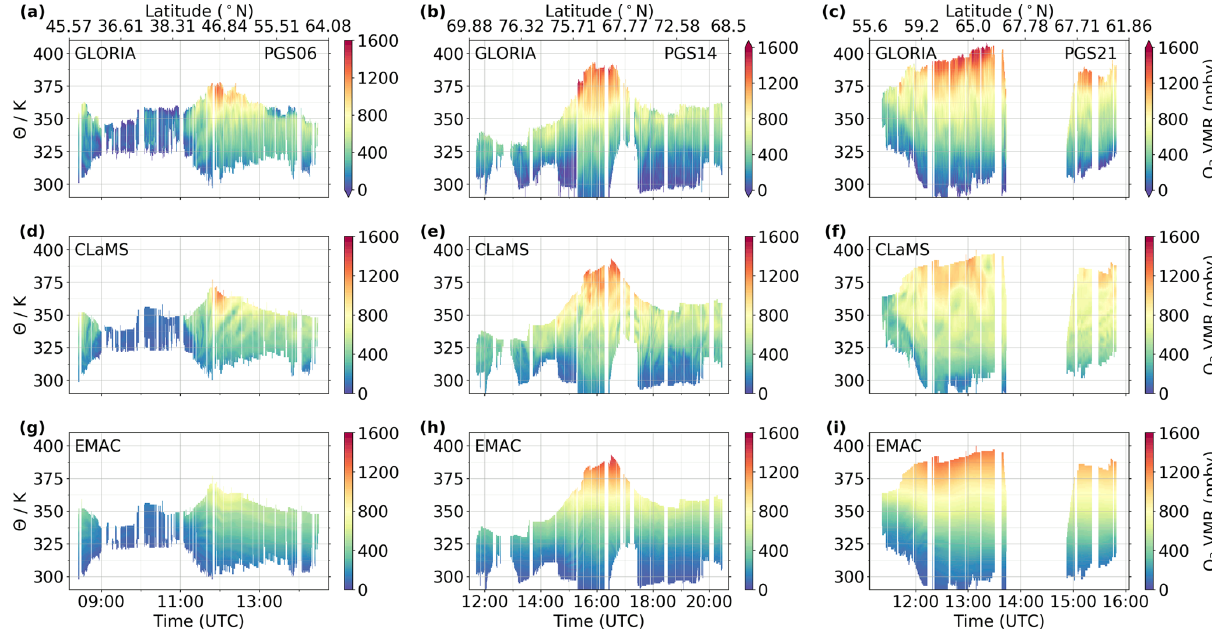
Figure 8. Comparison of GLORIA-measured ( a, d, g , repeated from Figs. 5 to 7 with a different color bar) to CLaMS- ( b, e, g ) and EMAC-simulated ( c, f, i ) O 3 cross sections for flights PGS06 (12 January 2016, a, b, c ), PGS14 (26 February 2016, d, e, f ), and PGS21 (18 March 2016, g, h, i ). Color bars with top and/or bottom arrowheads indicate data greater and/or smaller than the color bar